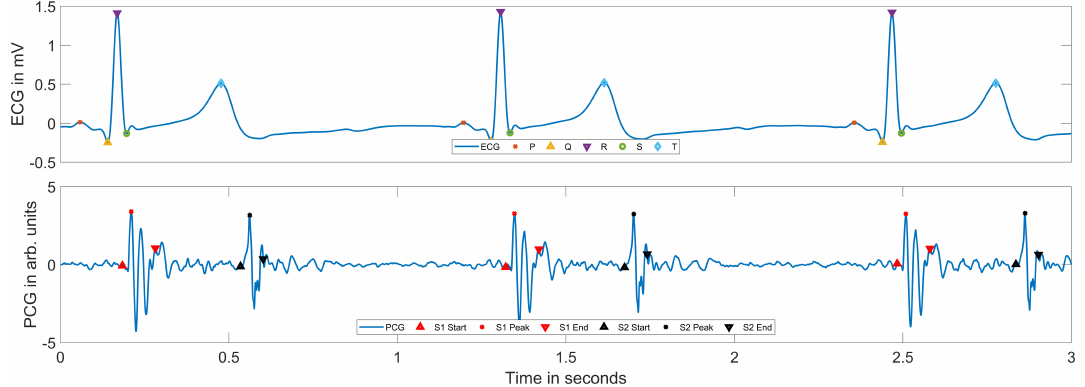
Figure 11. ECG and PCG signals with detected fiducial points.